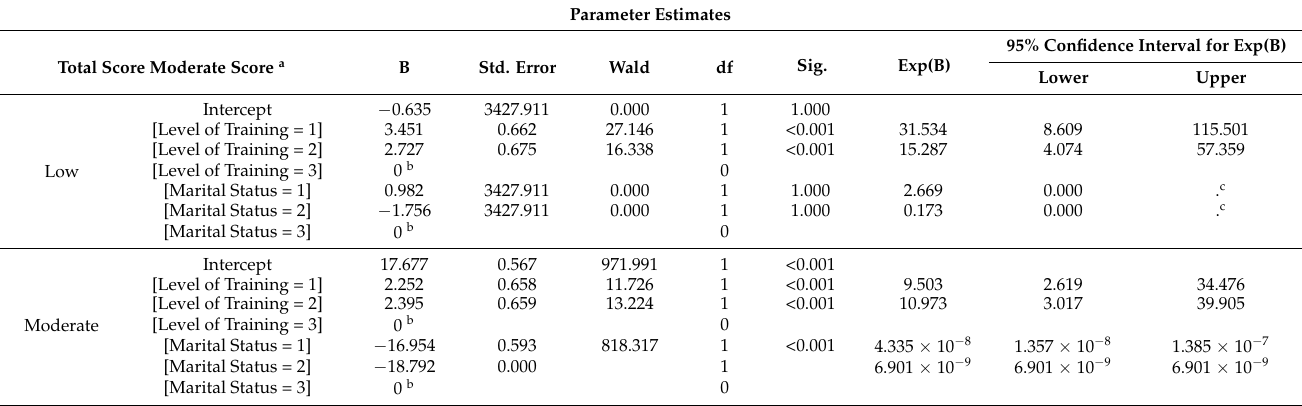
Table 5. The impact of marital status and clinical exposure on the participant’s knowledge scores. Parameter